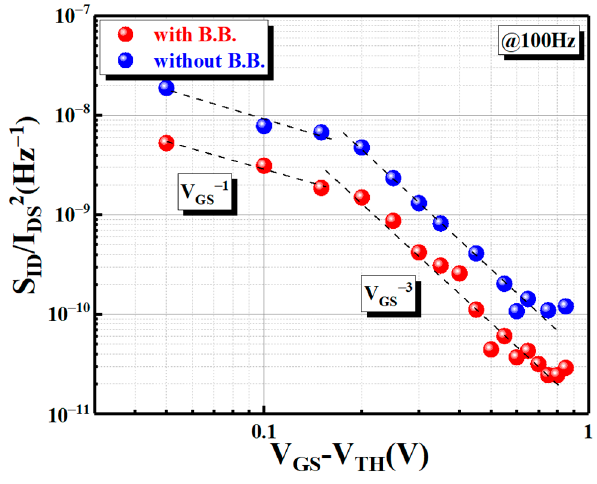
Figure 6. The measured low-frequency noise of devices with, and without, BB.